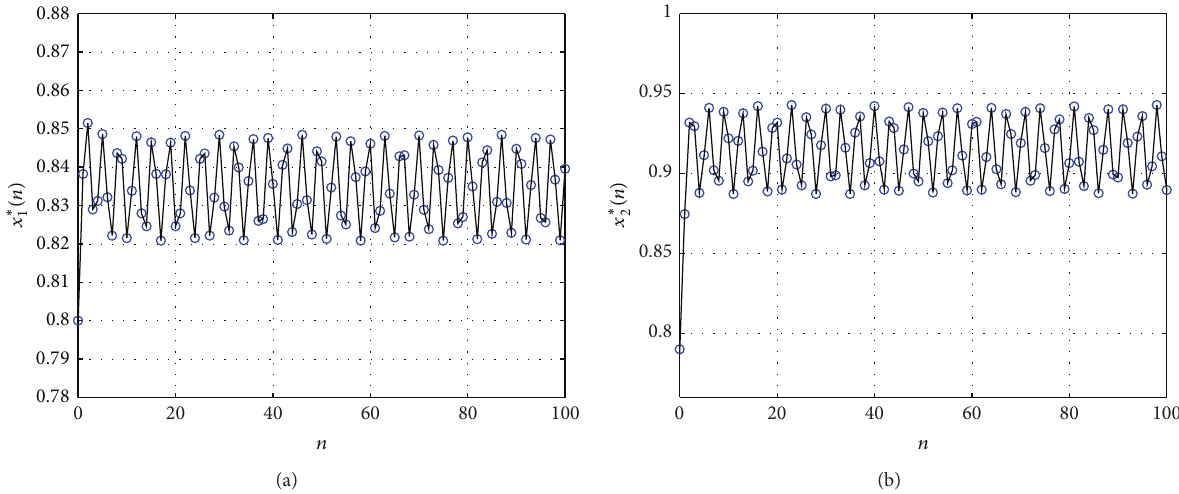
Figure 1: Positive almost periodic solution of system (50). (a) Time-series of 𝑥 ∗ 1 (𝑛) with initial values 𝑥 ∗ 1 (−1) = 0.79 and 𝑥 ∗ 1 (0) = 0.80 for 𝑛 ∈ [0,100] . (b) Time-series of 𝑥 ∗